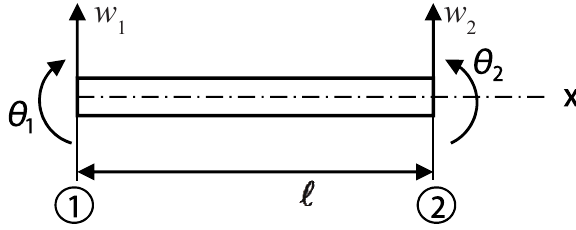
Fig. 2. Four degrees of freedom finite element